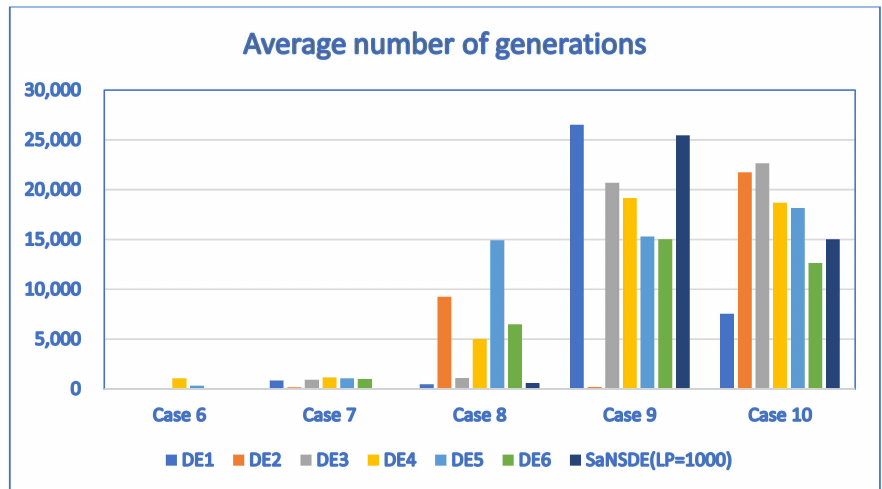
Figure 6. The average number of generations obtained by DE1, DE2, DE3, DE4, DE5, DE6 and SaNSDE with LP = 1000 for Case 6, Case 7, Case 8, Case 9 and Case